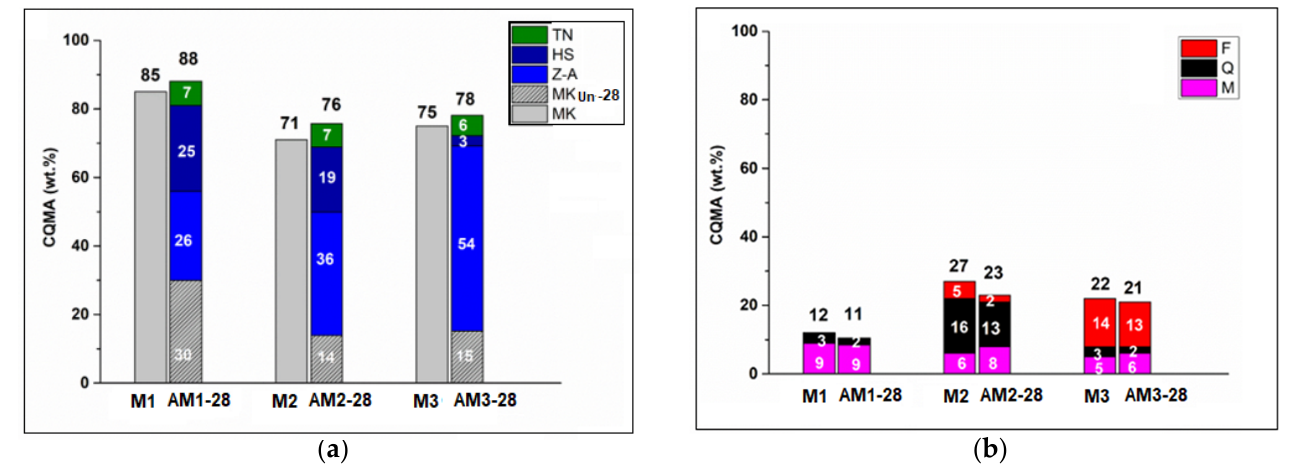
Figure 7. Graphical comparison of phases (wt. %) calculated by CQMA in: ( a ) MK in metakaolins (M) (left bar) and alkali-activated AM-28 products TN, HS, Z-A and MK Un -28 (right bar); ( b ) muscovite (M), quartz (Q) and orthoclase (F) in metakaolins (M) (left bar) and in alkali-activated AM-28 products (right bar).